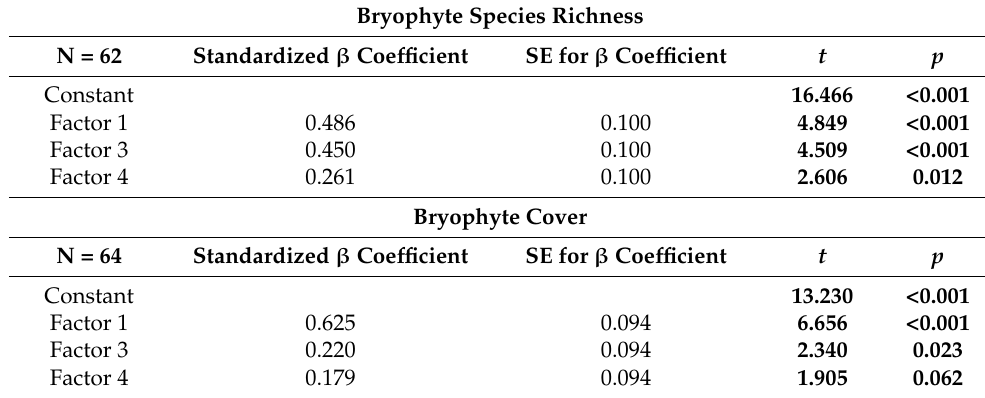
Table 2. Result of forward stepwise multiple regression analysis for the effect of factors related to habitat parameters on bryophyte species richness (R 2 = 0.45, F = 14.97, p < 0.05) and bryophyte cover (R 2 = 0.47, F = 17.70, p < 0.05). For a description of the factors, see Table 1. Variables with a significant effect ( p < 0.05) are provided in bold. The variables are listed according to the p -value.